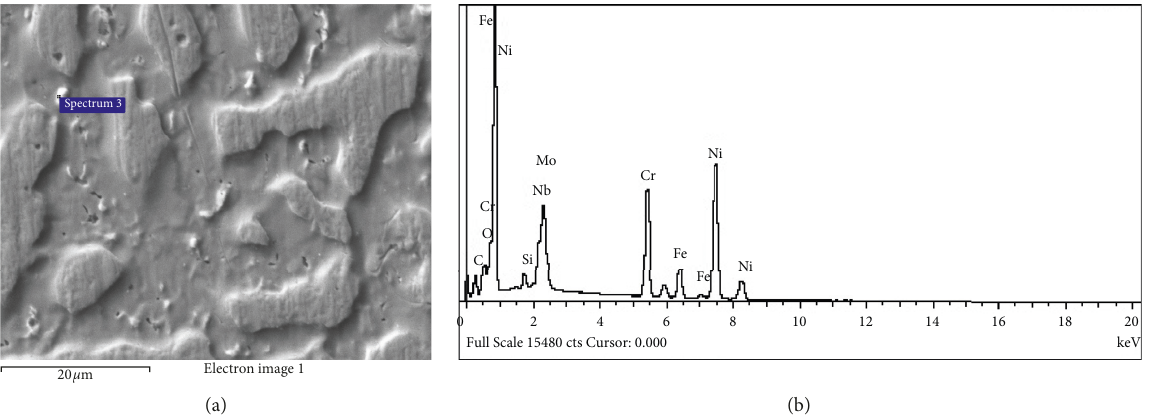
Figure 14: SEM images of inclusions and compositions in the near fracture zone of weld.